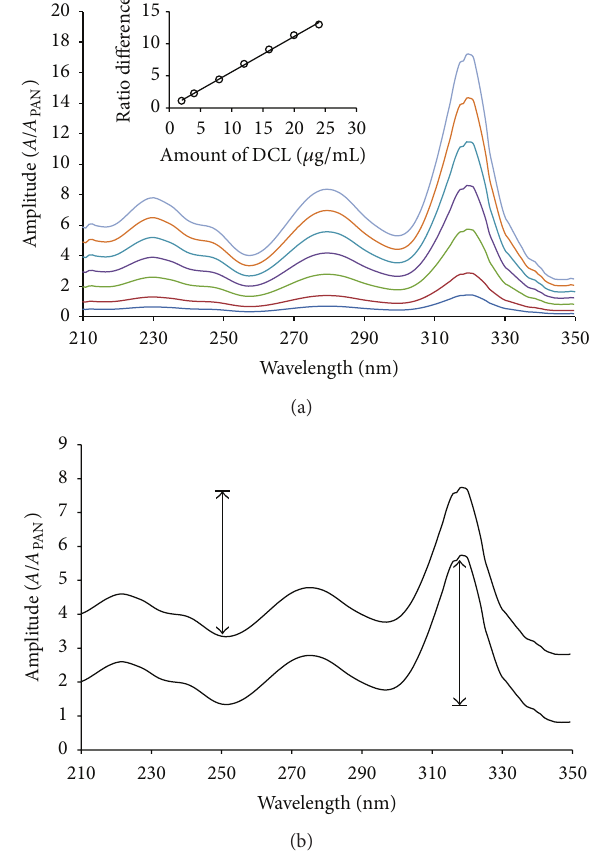
Figure 3: (a) Division spectra of 2.0–24.0 𝜇 g/mL diclofenac and (b) division spectra of a standard solution and a mixture solution containing the same concentration of diclofenac, using 4.0 𝜇 g/mL pantoprazole as a divisor and methanol as a